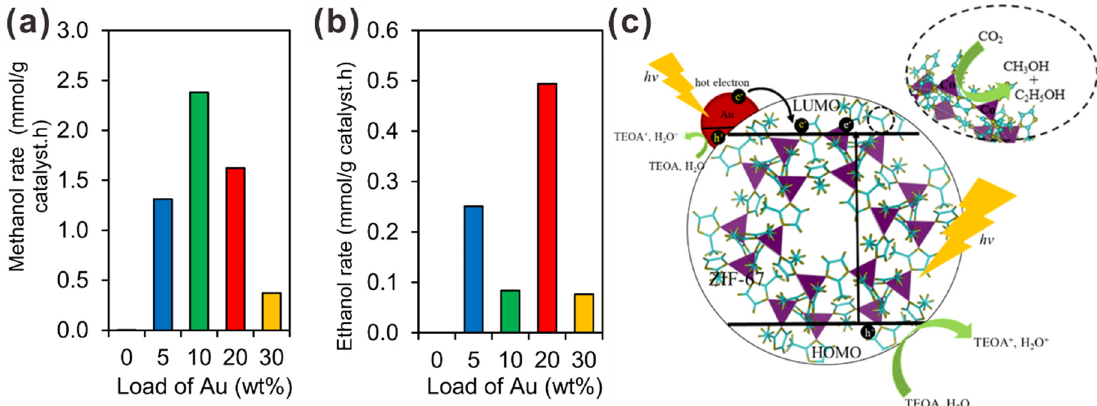
Figure 4. Photocatalytic activity of Au x @ZIF-67 for CO 2 reduction to ( a ) CH 3 OH and ( b ) C 2 H 5 OH, and ( c ) the mechanism of CO 2 photoreduction. Reproduced with permission from Reference [79]. Copyright 2020 American Chemical Society.